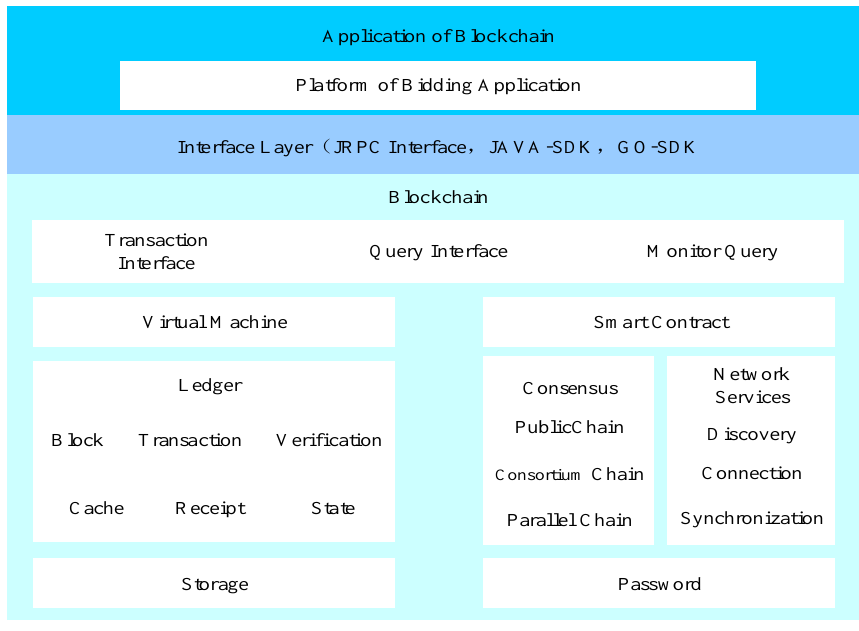
Figure 1. Architecture of the blockchain-based E-bidding system. Table 3. The components of blockchain.